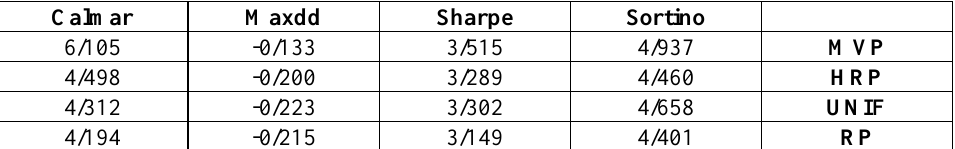
Table 4. Evaluation of in-sample optimization methods